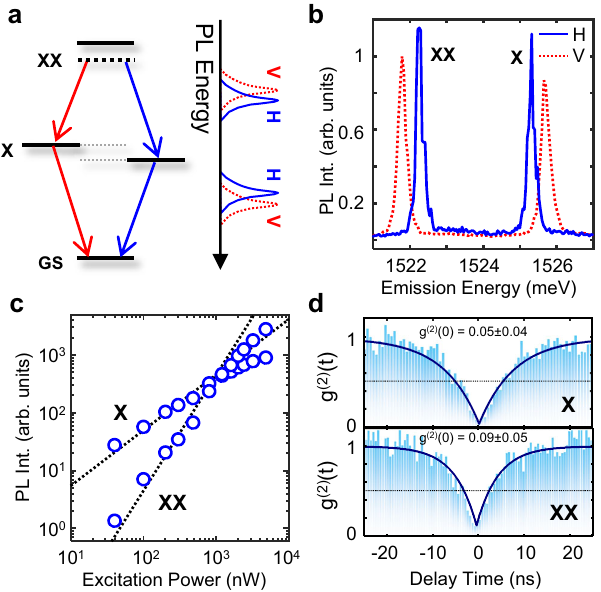
Fig. 3 Single-emitter photoluminescence and photon antibunching. a Schematic of a cascaded biexciton emission proces. GS, X, and XX denotes the ground-state, exciton, and the biexciton states respectively. Biexciton fi rst decays to an exciton either by emitting a vertically (V) or horizontally (H) polarized photon denoted by red or blue arrows respectively. Subsequently, the exciton decays to ground-state by emitting a second vertically or horizontally polarized photon with polarization correlated to the initial emitted photon, completing the emission cascade. The energy splitting between the different linear polarization arises due to the fi ne- structure splitting. b PL Spectrum of a single-quantum emitter. Two pairs of correlated doublets are observed. c PL intensity vs. Excitation Power: The localized defect exciton shows distinct behavior: Exciton (X) intensity increases sublinearly and begins to saturate at high powers as expected from a two-level system, whereas the biexciton line (XX) intensity increases superlinearly. Dashed lines are linear fi t (log (PL Int) = x log (Excitation Power)) to the data with extracted slopes of 0.96 for exciton (X) and 1.587 for biexciton (XX), respectively. d Second-order correlation measurement. Both X and XX exhibit g (2) (0) < 0.1, showing high-purity single-photon